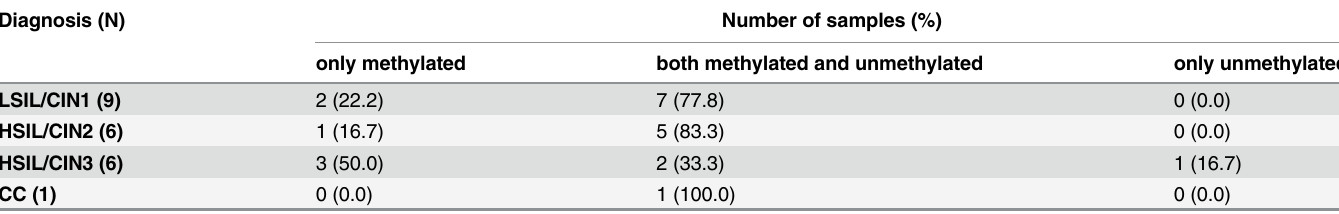
Table 3. HPV18 L1-gene methylation status HPV18 in 22 samples with mild, moderate and high grade dysplasia, and cervical cancer. Diagnosis